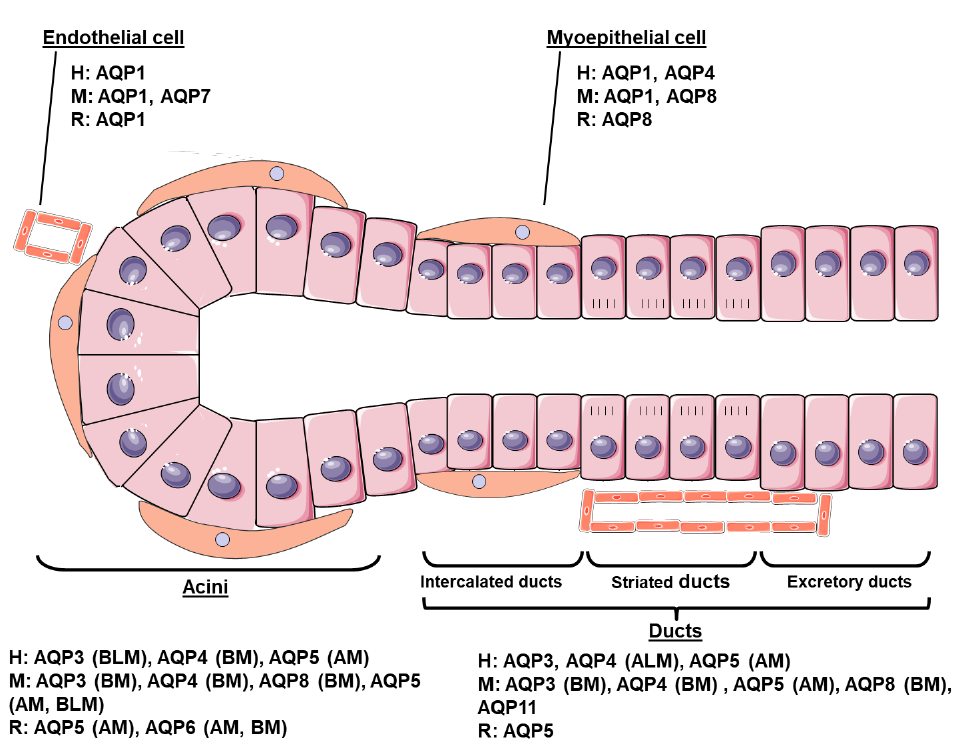
Figure 1. Cellular distribution of aquaporins (AQPs) in salivary glands (SG). Adult SG consist of acinar, ductal and myoepithelial cells. Acinar cells organize into secretory acini structures. Ductal cells organize into intercalated, striated and excretory ducts. Myoepithelial cells surround acini and intercalated ducts. Each cell type expresses some AQPs with particular subcellular localization. H: human; M: mouse; R: rat. AM: apical membrane; ALM: apicolateral membrane; BM: basal membrane; BLM: basolateral membrane.